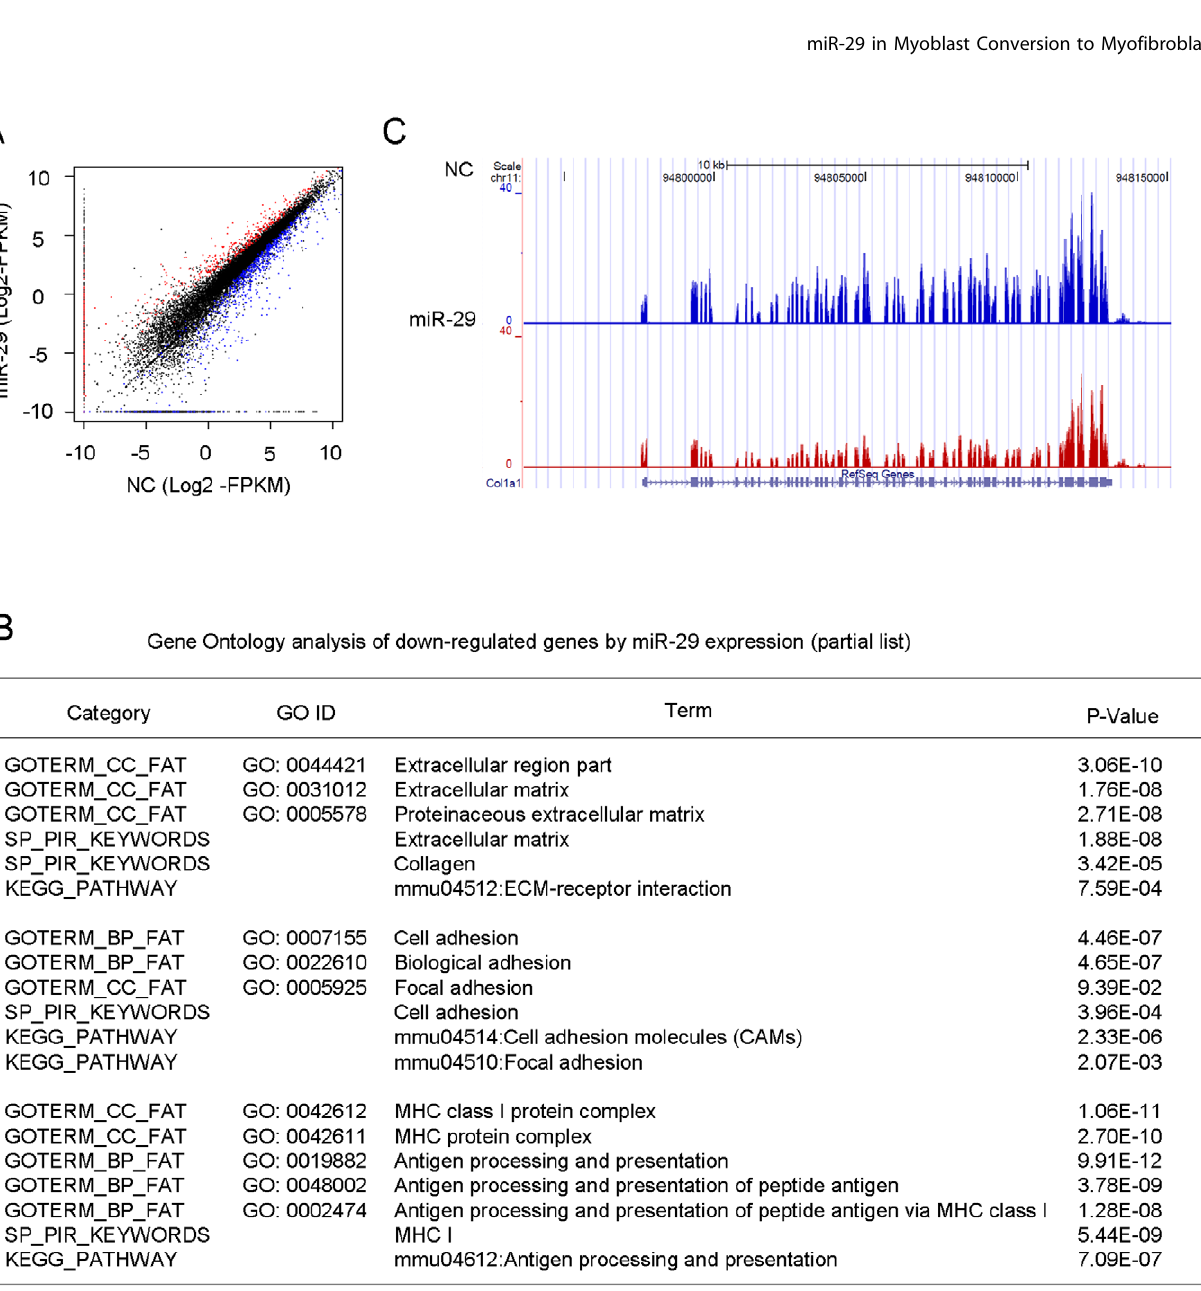
Figure 1. Stable over-expression of miR-29 in C2C12 cells down-regulates ECM and cell adhesion genes. (A) Differentially expressed genes between C2C12 cells stably expressing vector negative control (NC) and miR-29 were determined by RNA-seq. X- and Y-axis represent the log2 based FPKM values for expressed genes in NC and miR-29 samples, respectively. The black dots represent genes with no significant expression changes between NC and miR-29 samples. The red dots represent genes with significant expression changes. The blue dots represent genes that have expression signal in only one sample but absent in the other. (B) Over-represented GO terms by GO analysis of down-regulated list of genes. CC: cellular component; BP: biological process. SP_PIR: a database of protein super-family names; KEGG: Kyoto Encyclopedia of Genes and Genomes. (C) Coverage plot showing a , 20 kb region encompassing the Collagen 1A1 (Col) gene on chromosome (Chr) 11; the gene structure is shown in blue below the